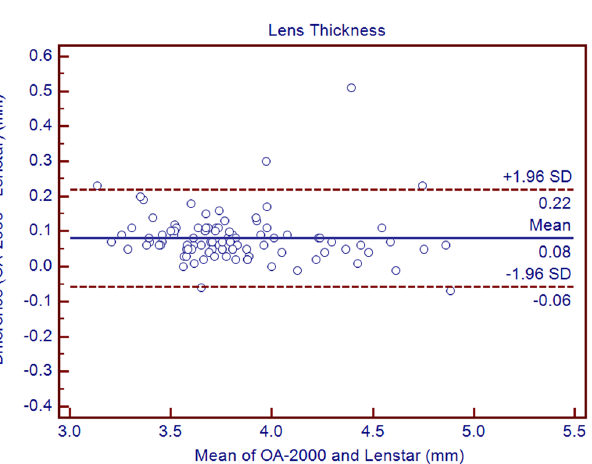
Figure 2. Bland-Altman plots show the agreement between OA-2000 swept-source optical coherence tomography and Lenstar optical low coherence reflectometry for measuring central corneal thickness. Solid lines represent the bias between both devices and dotted lines represent the 95% confidence interval for the difference.